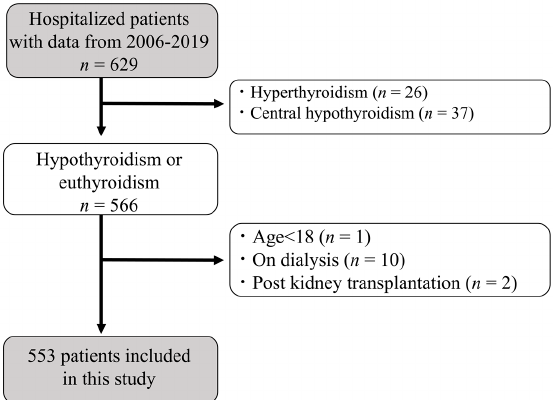
Figure 1. Flow diagram of the screening and enrollment of study patients.